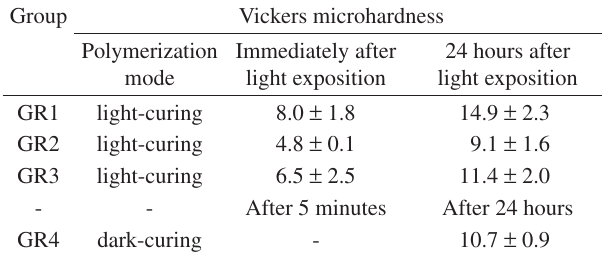
Table 3. Vickers microhardness of the different specimen groups.